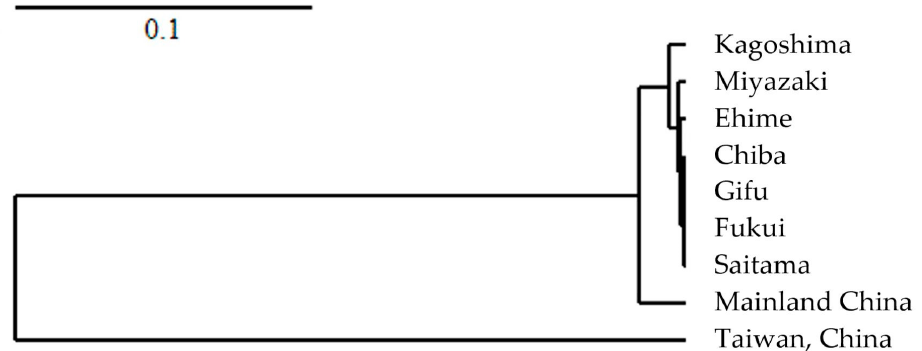
Figure 3. Hierarchical clustering for tetraploid isolates in each population calculated using PolyGene software. Dendrogram generated with the UPGMA clustering method based on Nei’s standard genetic distances.